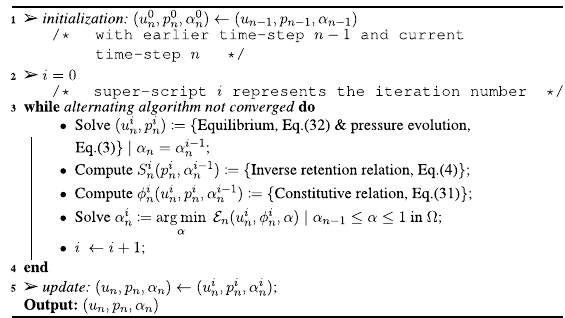
Algorithm 1. Alternating algorithm for the capillary damage